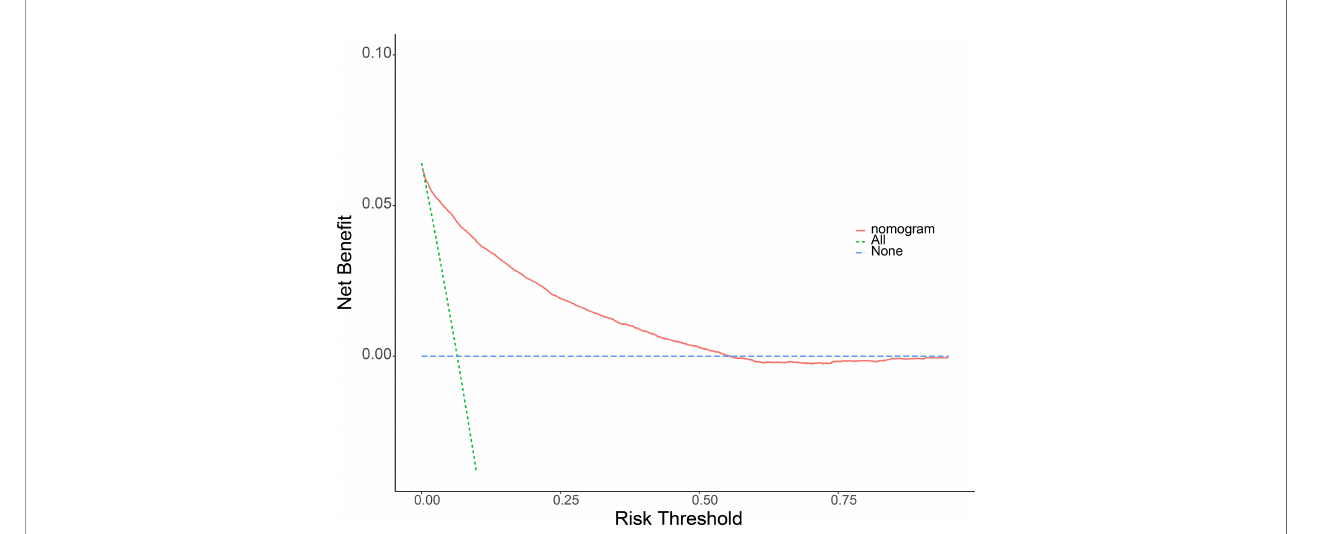
FIGURE 4 | Decision curve analysis (DCA) of the nomogram for predicting LMs in patients with RCC in the training cohort (A) and the validation cohort (B) . The blue line represents the hypothesis that all RCC patients do not have lymphatic metastasis. The green line represents the hypothesis that all patients with RCC present lymphatic metastasis. The red line represents the nomogram. The y-axis represents net bene fi t, and the x-axis represents threshold probability. This diagnostic nomogram shows a notable positive net bene fi t, indicating that it has a good clinical utility in predicting estimating the risk of LMs in patients with RCC.